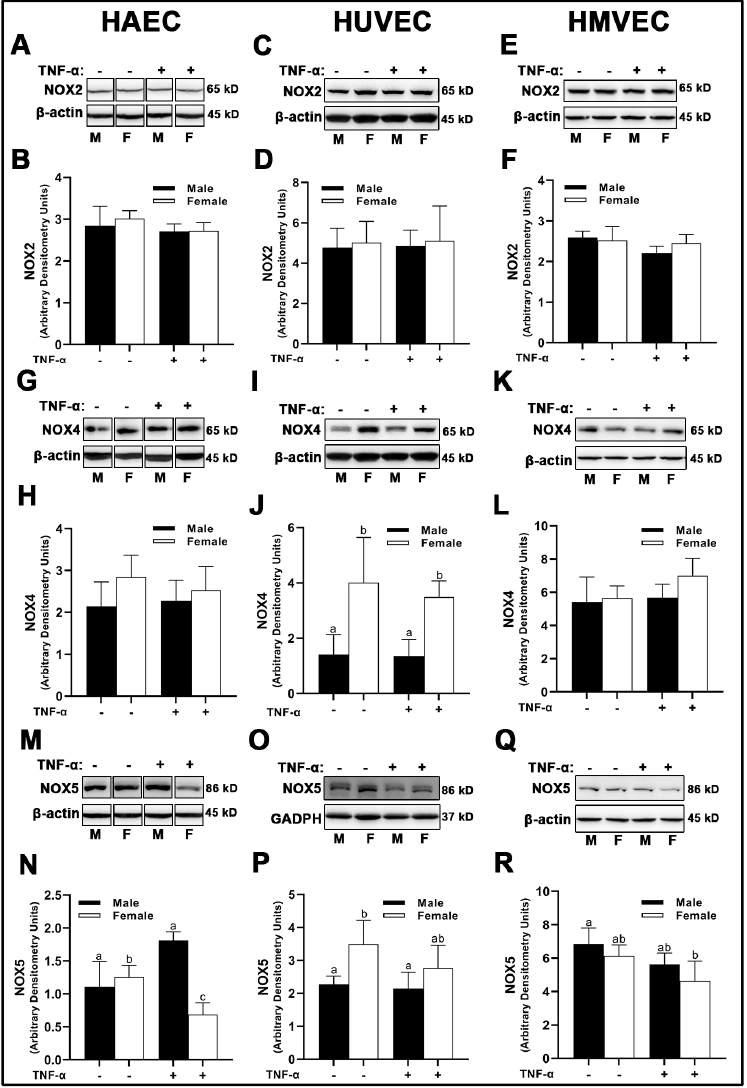
Figure 4. Expression of pro-oxidant NOX isoforms in male and female endothelial cells. HAECs, HUVECs and HMVECs were cultured in starvation medium at ~80% confluency for 24 h with or without TNF- α (20 ng/mL). Protein expression of NOX2 ( A – F ), NOX4 ( G – L ) and NOX5 ( M – R ) were determined by Western blot. Quantification was performed using Image Lab (Bio-Rad Laboratories, Inc.). Protein was normalized to respective control bands ( β -actin or GAPDH). Data are expressed as mean ± SD from 4–6 experiments. Data were statistically analyzed with one-way ANOVA followed by Tukey post hoc multiple comparison analysis between groups. Values that do not share the same letter are significantly different from each other (p ≤ 0.05).